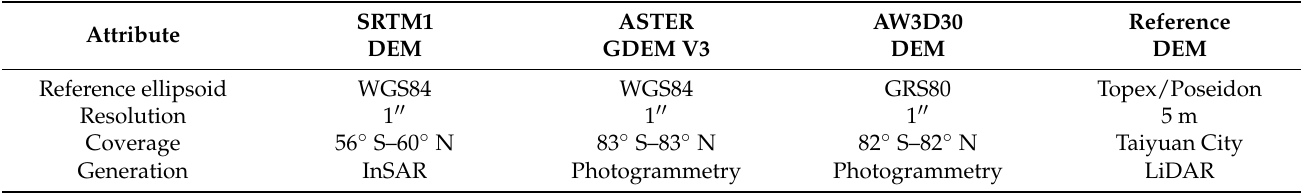
Table 1. The information of experimental